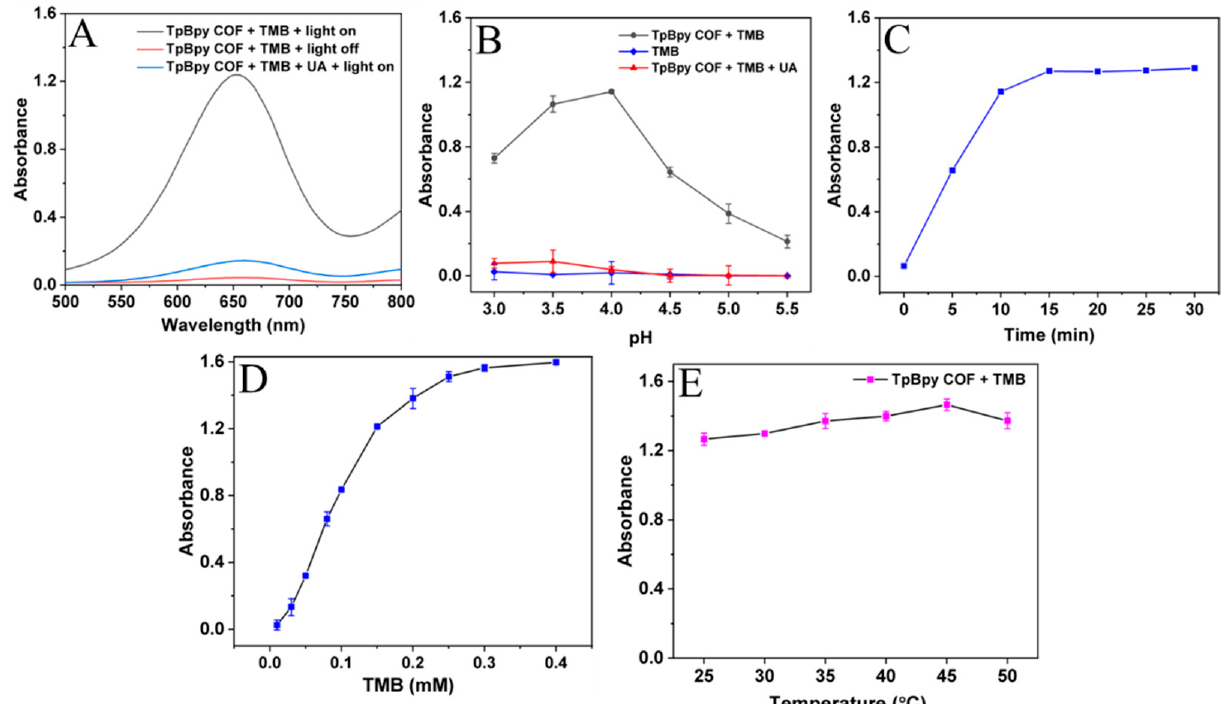
Figure 4. ( A ) UV ‐ vis spectra of TpBpy COF + TMB system with/without the presence of UA. ( B ) Figure 4. ( A ) UV-vis spectra of TpBpy COF + TMB system with/without the presence of The effect of pH on the absorbance at 652 nm of TpBpy COF + TMB, TpBpy COF, TMB, TpBpy COF + TMB + UA under visible light irradiation. The effect of irradiation time ( C ), TMB concentra ‐ tion ( D ), and temperature ( E ) on the absorbance at 652 nm of TpBpy COF + TMB.